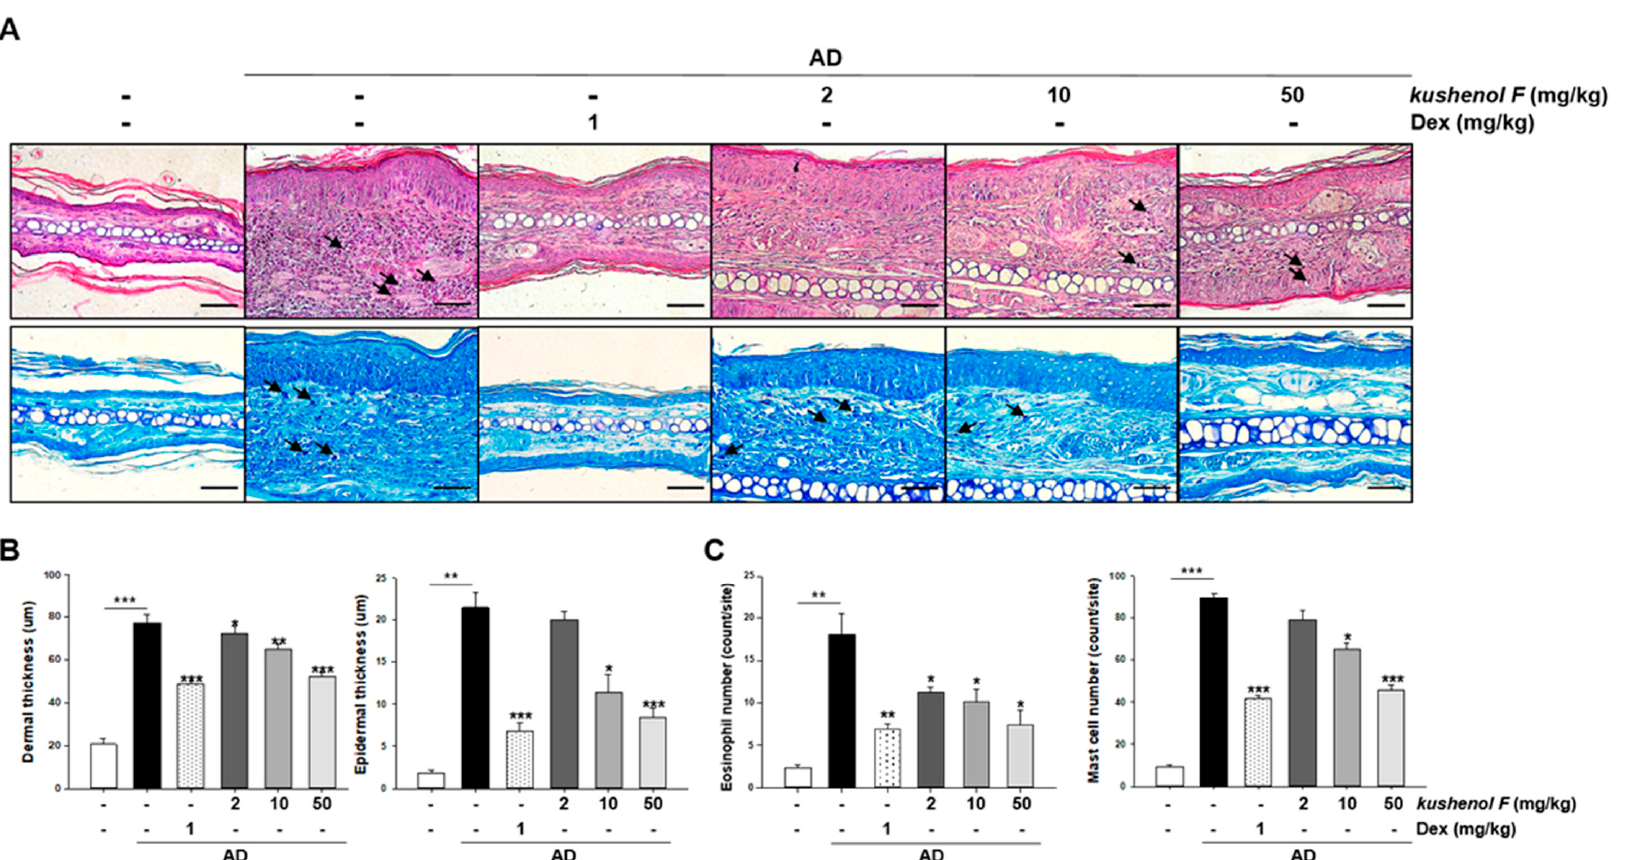
Figure 3. Comparison of the histopathological analysis of dorsal skin lesions in DFE/DNCB-treated atopic dermatitis mice with mice treated with kushenol F. ( A ) Representative photomicrographs of ear sections stained with H&E (upper panel arrow, eosinophil cells) or toluidine blue (lower panel arrow, mast cells). Scale bar = 10 µ m. ( B ) Epidermal and dermal thickness ( µ m). ( C ) Number of cells is presented as the mean number of cells at five random sites for each animal. Data are presented as the mean ± SD ( n = 5). * p < 0.05, ** p < 0.01 and *** p < 0.001 vs. control. DFE, Dermatophagoides farinae extract; DNCB, 1-chloro-2,4-dinitrochloro- benzene.